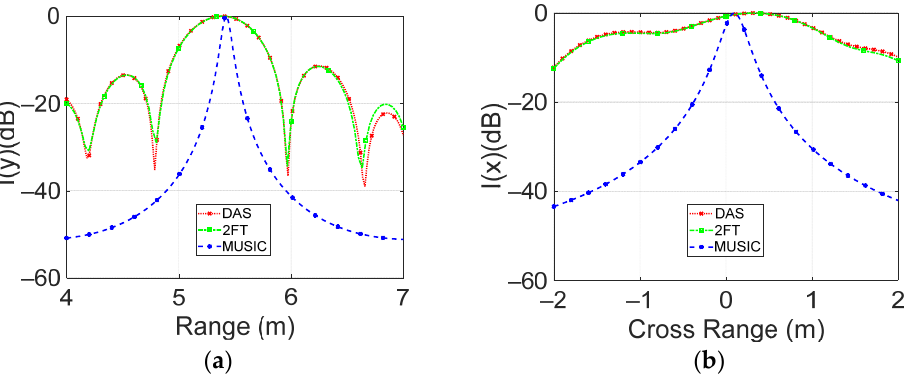
Figure 19. The normalized intensity function versus ( a ) range and ( b ) cross-range distance is reported. Panel distance is 5.4 m away from the radar antenna.